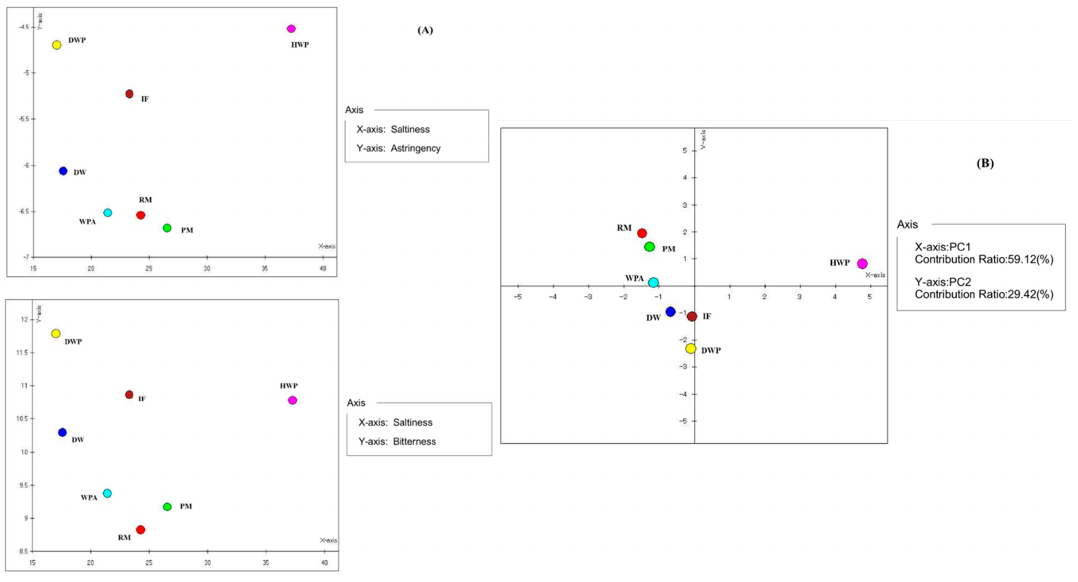
Figure 7. The scatter plot, Saltness-Bitterness and Saltness-Astringency ( A ) and principal component results of E-tongue ( B ). RM, raw milk; PM, pasteurized milk; DW, demineralized whey; DWP, demineralized whey powder; HWP, hydrolyzed whey protein powder; WPA, whey protein powder with added alpha-lactalbumin; IF, infant formula. Most of the sensors showed a negative correlation in E-nose and E-tongue (Figure 8).